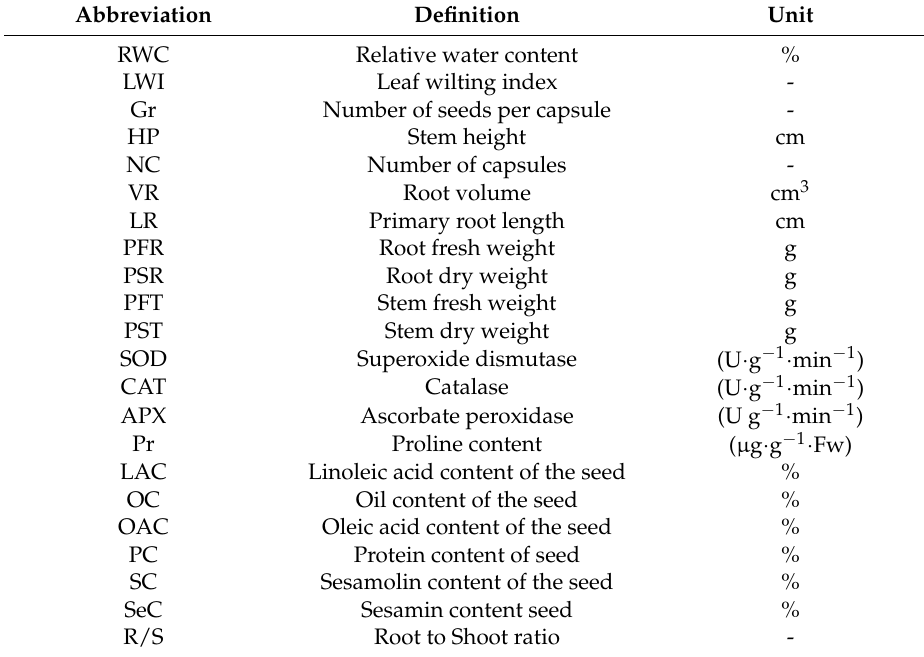
Table 1. Abbreviations, Definitions and Units of the Studied Parameters.